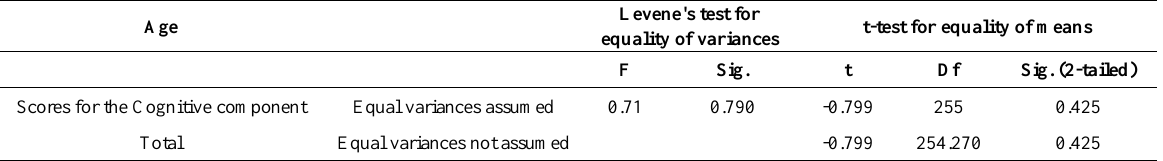
Table 2. t-Test – Scores for the cognitive component of the respondents’ attitudes towards inclusive education – age groups Age